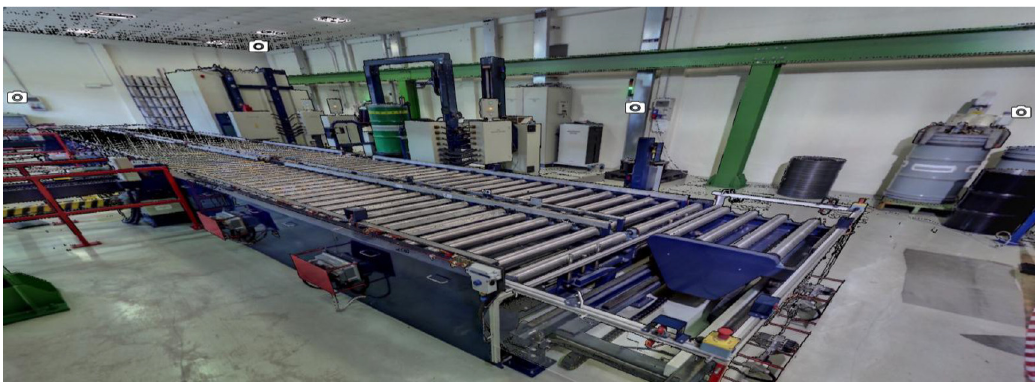
Fig. 8. Tomography of waste drums in the characterisation/clearance stage.